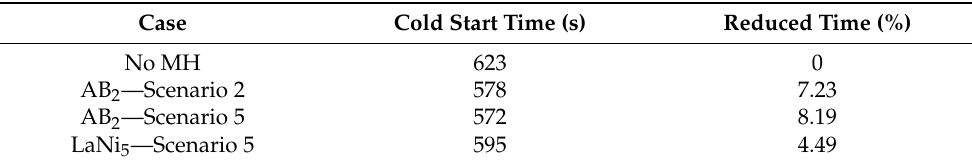
Figure 7. PEMFC temperature when it is thermally coupled with metal hydride. ( a ) presents the total temperature profile for all the 4 scenarios studied. For clarity, ( b ) shows the temperature profile for the first 100 s, ( c ) the profile between 100–400 s, ( d ) illustrates the temperature profile for last 200 s of the measurement (400–600 s). Table 6. Cold start time for all the simulated